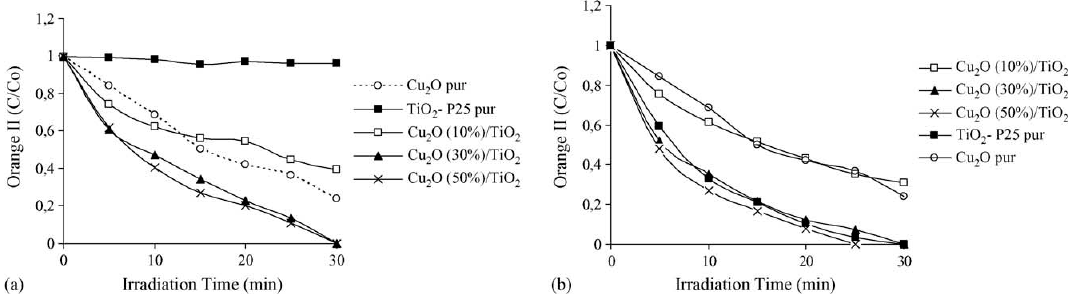
Figure 10. Photocatalytic degradation of Orange II in Cu 2 O/TiO 2 system under: ( a ) visible irradiation and ( b ) UV–vis irradiation. Reprinted with permission from [70]. Copyright Elsevier, 2005.